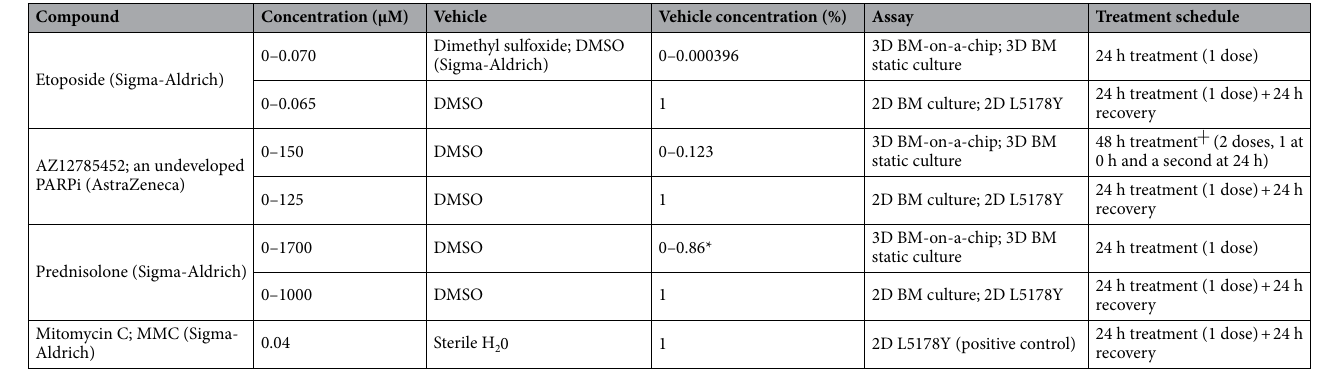
Table 1. Compounds used in the 2D and 3D assays. ┼ Dosing regimen was selected to align with that used in the in vivo study. *The highest DMSO concentration used in the 3D assays did not negatively affect cell viability as tested by 7-AAD + staining in flow